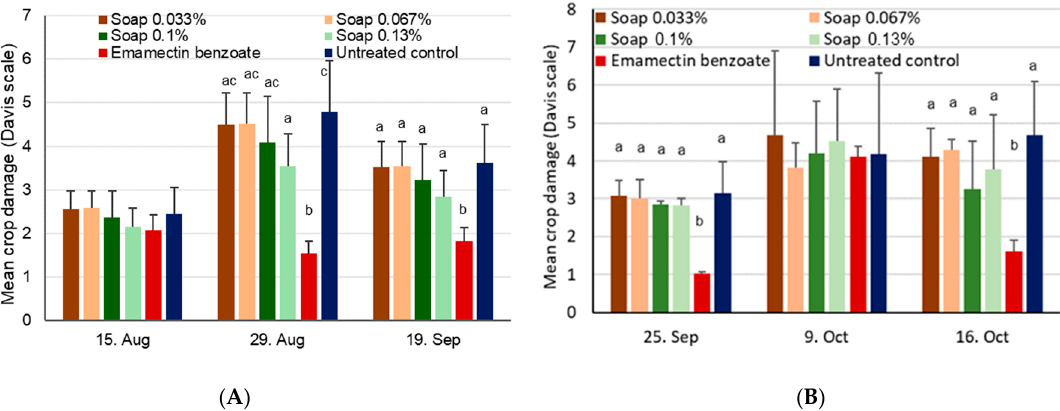
Figure 11. Mean crop damage induced by FAW + SD after application of alata samina, a local soap, at different concentrations during vegetative growing stages conducted in the 2018 season. For a given date, bars sharing the same letters are not significantly different from each other, while missing letters indicate a lack of differences. ( A ) Site 1 near Wa, Upper West, Ghana, where treatments were applied on 16 August, 30 August, and 13 September. ( B ) Site 2 near Accra, Ghana, where treatments were applied on 20 September and 10 October.